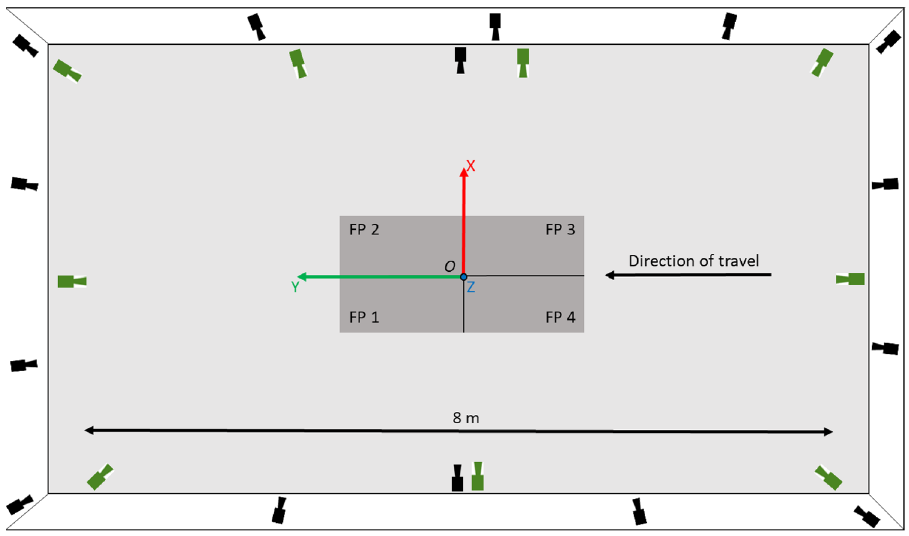
Figure 1. Birds-eye view detailing the layout of the capture volume. Four force plates (FP) are shown in the centre in dark grey. Black cameras depict Qualysis camera locations, green cameras depict JAI machine vision camera locations. The origin of a right-handed coordinate system was set in the centre of the force plates at position O with the positive z-axis set normal to the X–Y floor